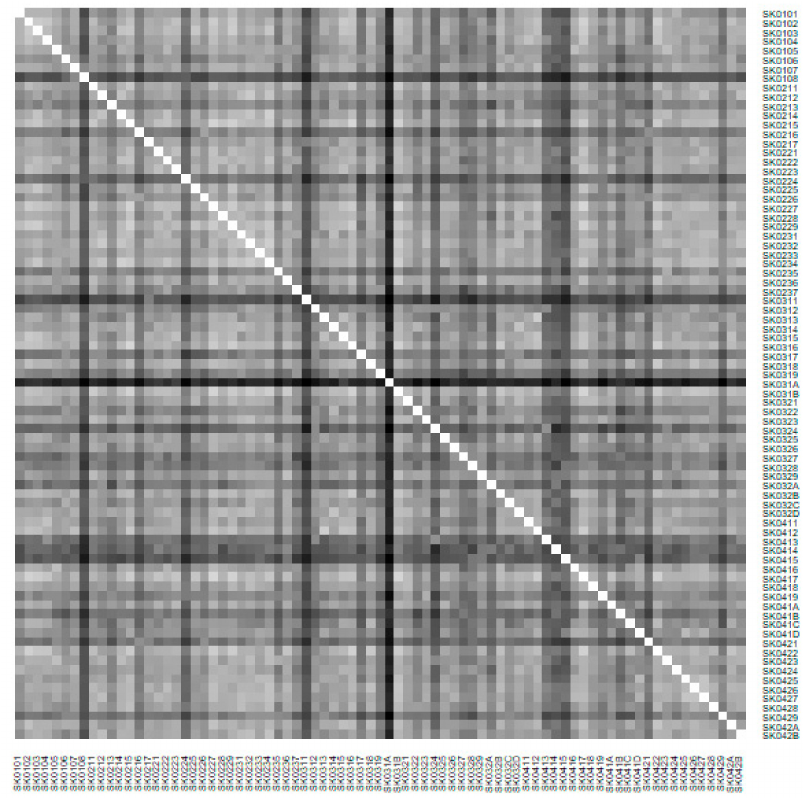
Figure 23. Preventable mortality heat map of the districts for the male sex in the year 2008. Source: own elaboration by the